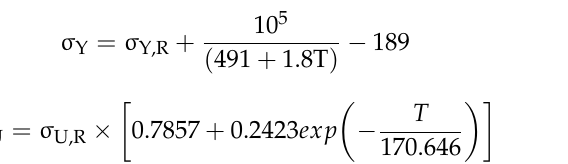
Table 3. Mechanical properties of API 2W Gr.50 steel at room